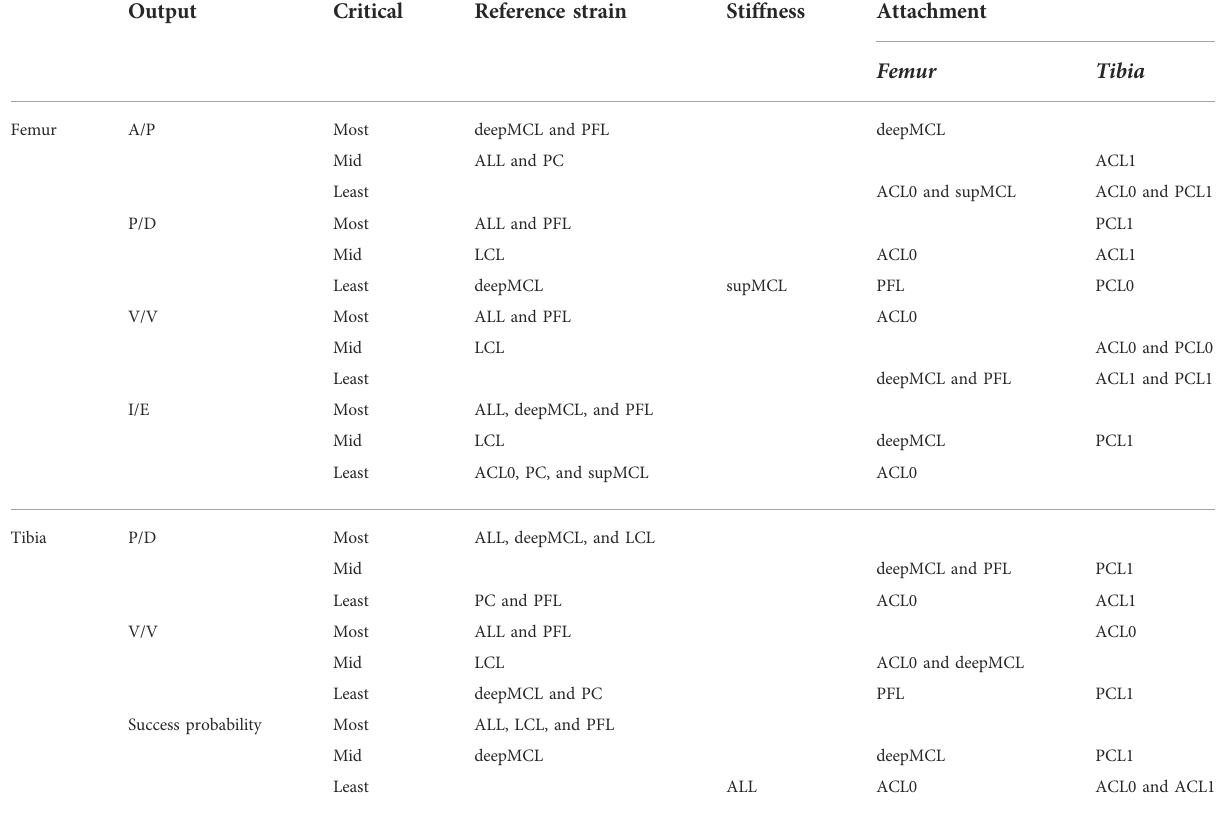
TABLE 4 Ten most critical ligament properties (out of 50) for the critical implant position parameters and success probability. The 10 most critical ligament properties are further classi fi ed into the three most critical, three mid-critical, and four least